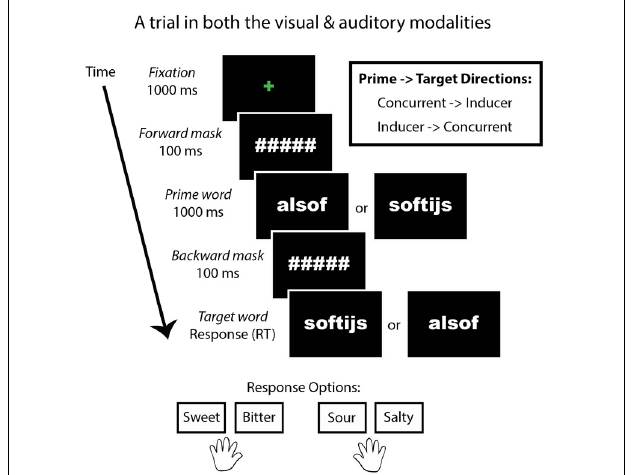
FIGURE 1 | A trial from the priming task. This task was presented in both a visual and auditory modality. Congruency refers to whether the type of tastes of the prime and target words were congruent (e.g., sweet–sweet) or incongruent (e.g., sweet–sour). Direction refers to whether the prime and target words were presented in SC’s inducer-concurrent (I-C) direction or concurrent-inducer (C-I)